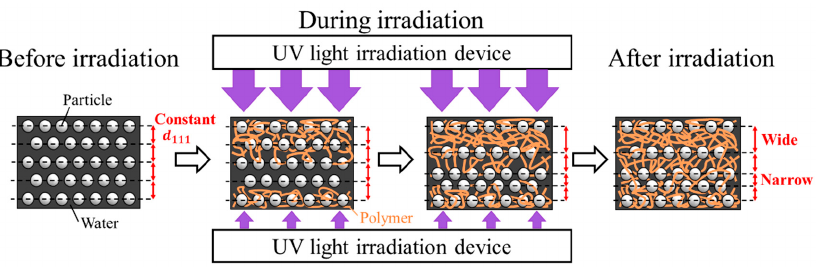
Figure 3. Schematic diagram of mechanism likely responsible for changes in lattice spacing in thickness direction during photopolymerization at different top- and bottom-light